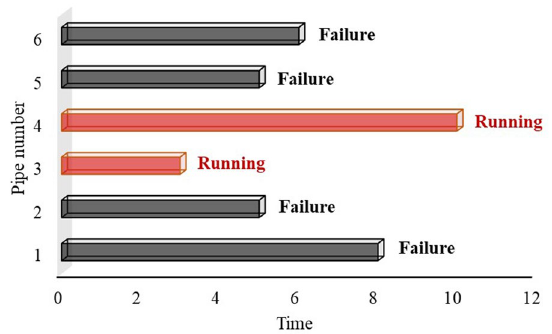
Fig. 3 Censored data (Modified from Snider and McBean